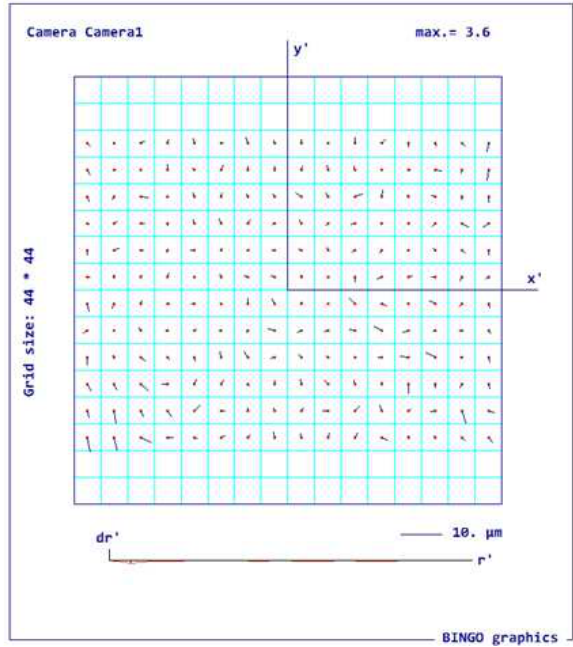
Figure 11: t he remaining errors and their directions can be seen on a selected camera.